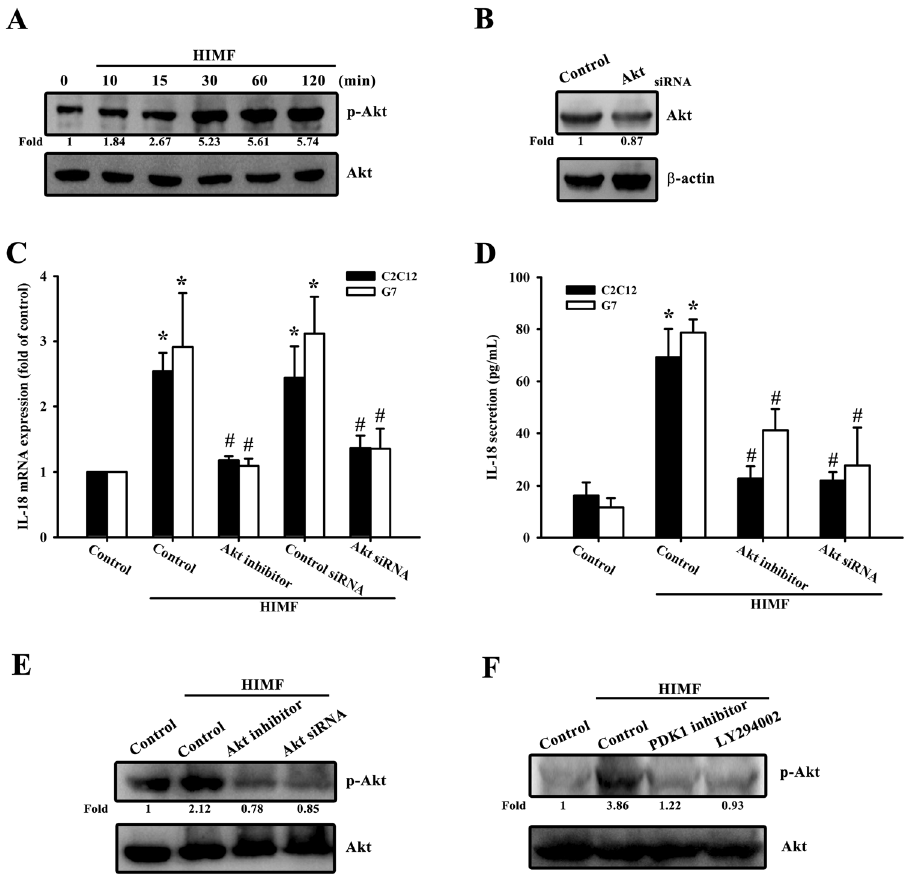
Figure 4. Akt is involved in HIMF-induced IL-18 production. ( A ) Cells were incubated with HIMF (3 nM) for indicated time intervals and cell lysates were immunoblotted with an antibody specific for phospho-Akt. ( B ) Cells were transfected with Akt siRNA for 24 h, and Akt protein expression was analyzed. ( C ) HIMF-induced IL-18 mRNA was inhibited by the Akt inhibitor or Akt siRNA. ( D ) Cells were pretreated for 30 min with the Akt inhibitor or transfected with Akt siRNA for 24 h, then stimulated with HIMF for 24 h, and the conditioned media was collected and examined by ELISA. ( E ) HIMF-induced Akt phosphorylation was inhibited by an Akt inhibitor or Akt siRNA. ( F ) Cells were treated with the PDK1 inhibitor or LY294002 for 30 min then stimulated with HIMF for 120 min, and phospho-Akt protein expression was analyzed. Results are expressed as the means ± SEM of four independent experiments. * p < 0.05 as compared with the control group. #p < 0.05 as compared with HIMF-treated